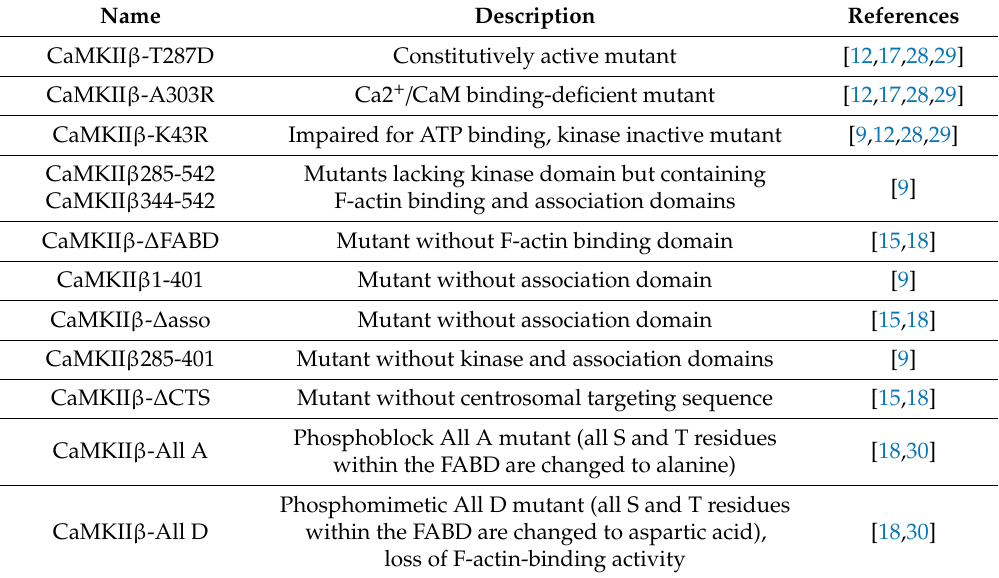
Table 2. CaMKII β mutants.